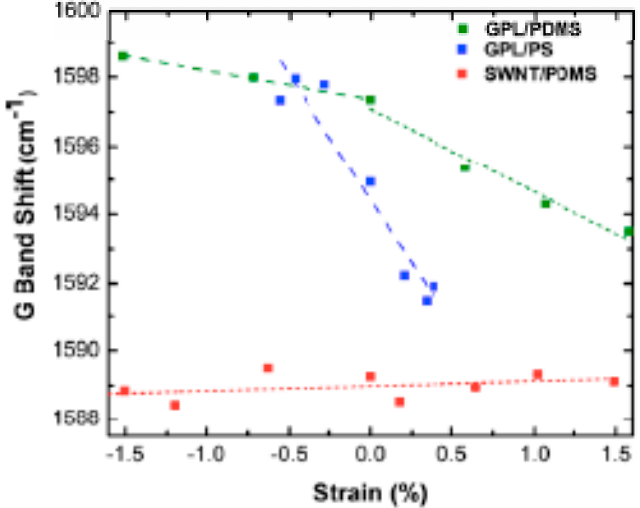
Figure 9. Comparison of Raman G-band peak shift in tension and compression of graphene platelets/poly(dimethylsiloxane) (GPL/PDMS), single-walled carbon nanotubes/poly(dimethylsiloxane) (SWCNT/PDMS) and graphene platelets/ polystyrene (GPL/PS) nanocomposites below 2% applied strain at a constant weight fraction of ~0.1%. Reprinted from reference [83] with permission from AIP Publishing LLC.